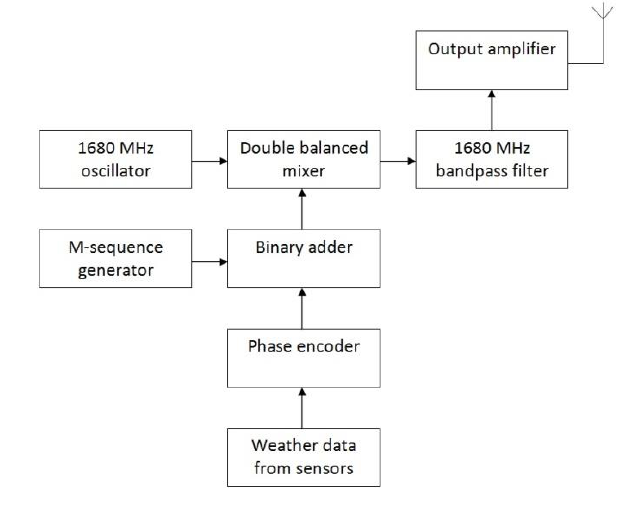
Fig. 2. Block diagram of the ARS transmitter with a spread spectrum